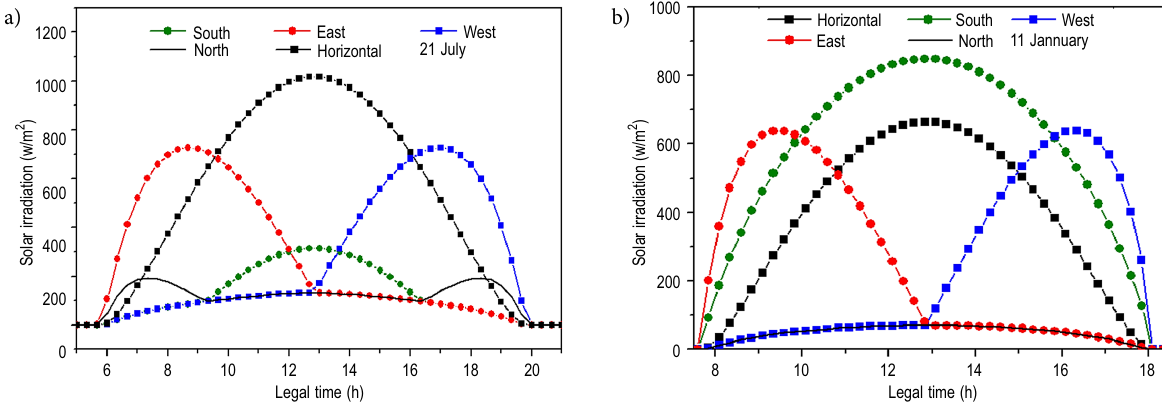
Fig. 4. Solar radiation at the exterior zone façades: the 21 of July (a) and 21 of January